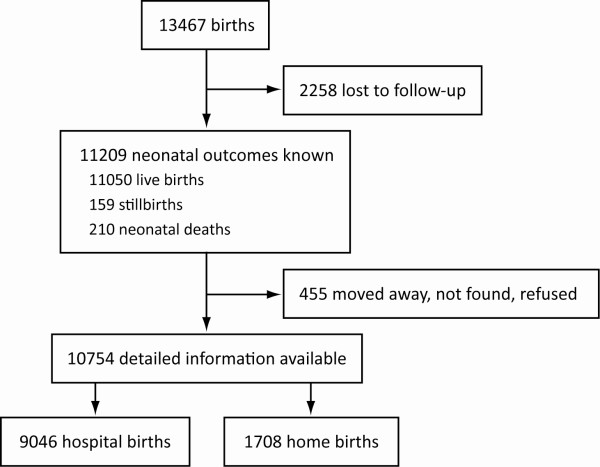
Study flow chart.